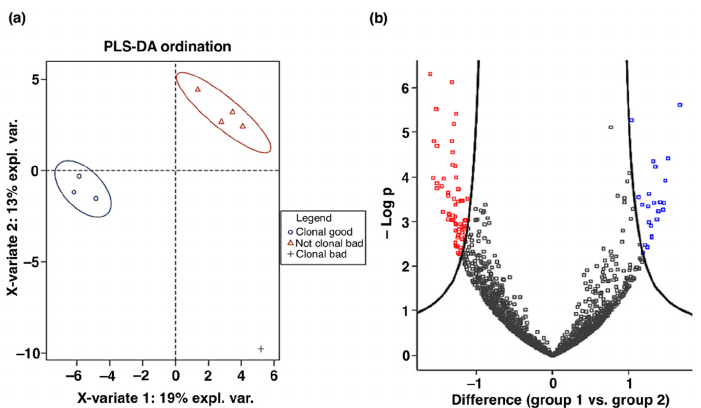
Figure 4. Proteome analysis in H9 cells with different phenotypes. ( a ) Three groups of H9 cells in the partial least squares discriminant (PLS-DA) analysis of the expressed proteins. The ellipses indicate the 95% confidence domains for each group. ( b ) Volcano plot showing statistically significant differences in the expression of proteins in experimental group 1 (good clonal cells) compared to group 2 (non-clonal cells with differentiation). Student’s T-test difference is shown on the horizontal axis, and minus logarithm of adjusted p -value on the vertical axis. Down-regulated proteins are highlighted in red, and up-regulated proteins are highlighted in blue.